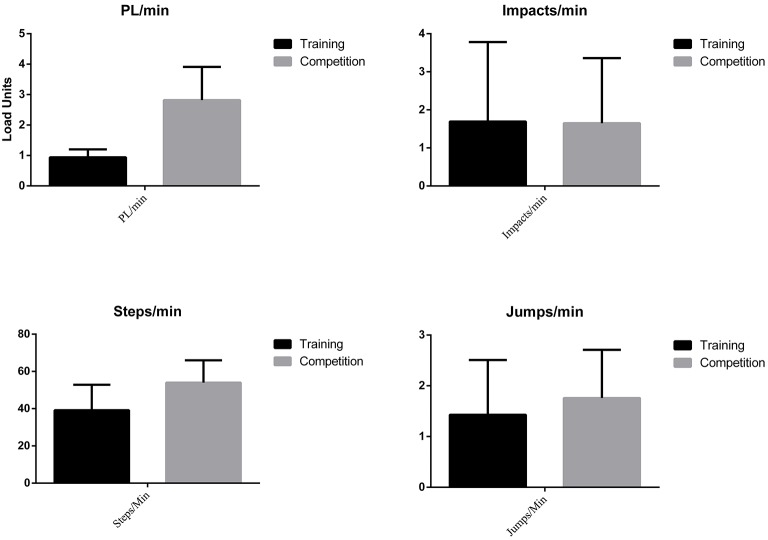
External load by Game Situation.